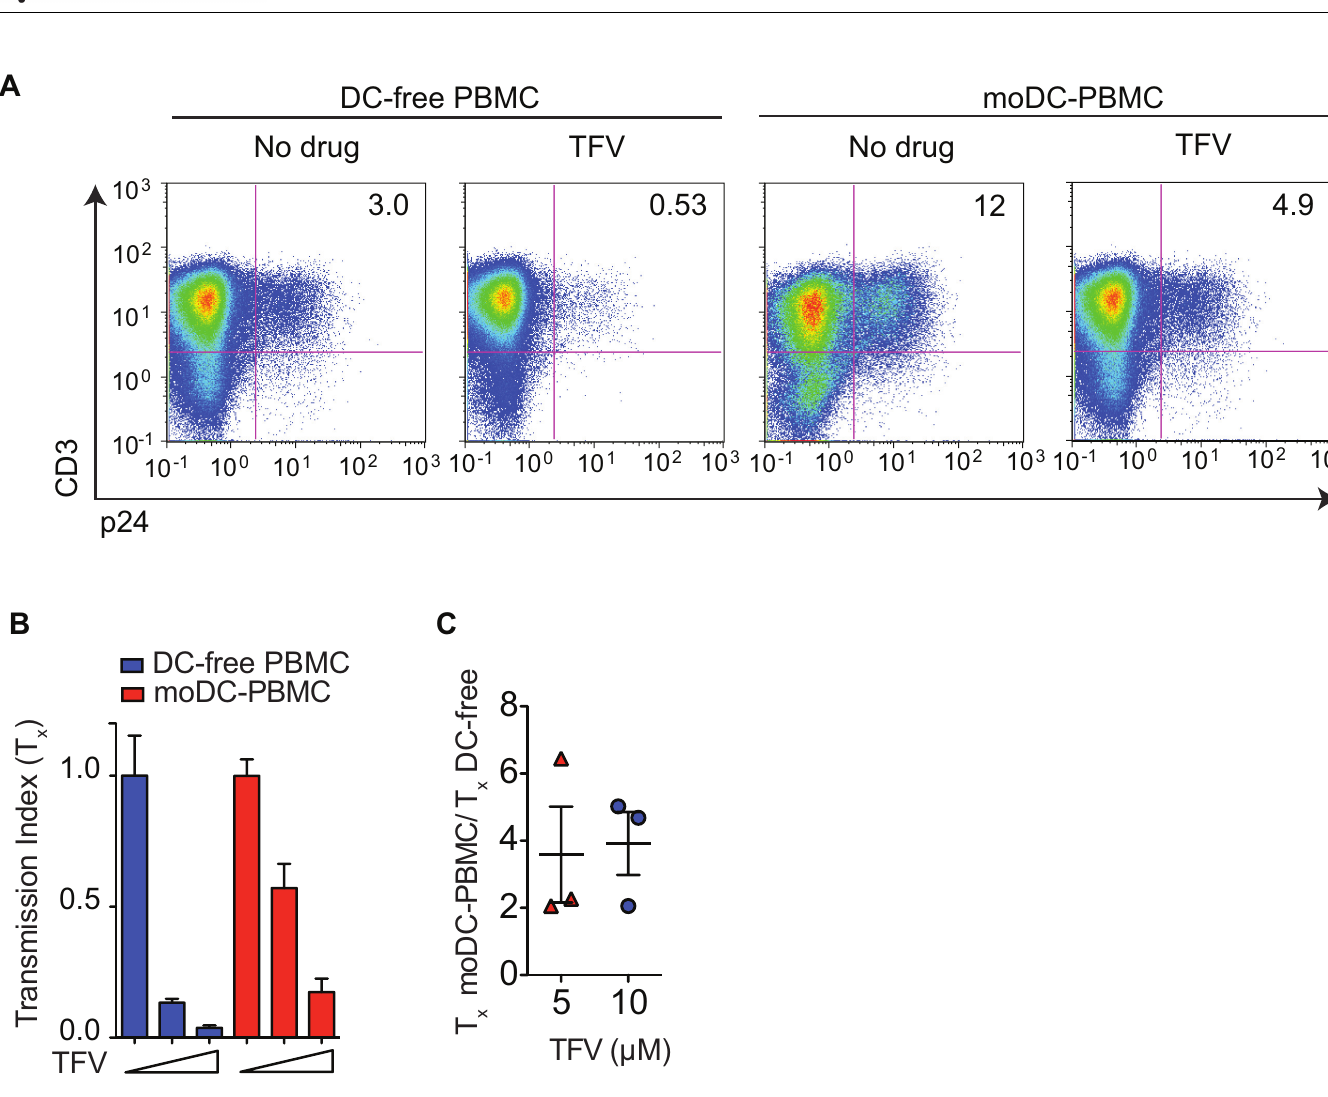
Fig 2. moDC-to-PBMC infection is insensitive to TFV. ( A ) FACS plots of DC-free T cell or moDC-to-PBMC infection in the absence of presence of 5 μ M of TFV. ( B ) Drug insensitivity measured by transmission index (T x ) of DC-free culture or moDC-T cell coculture. TFV at 0 μ M, 5 μ M, 10 μ M (wedges). ( C ) Fold difference between the